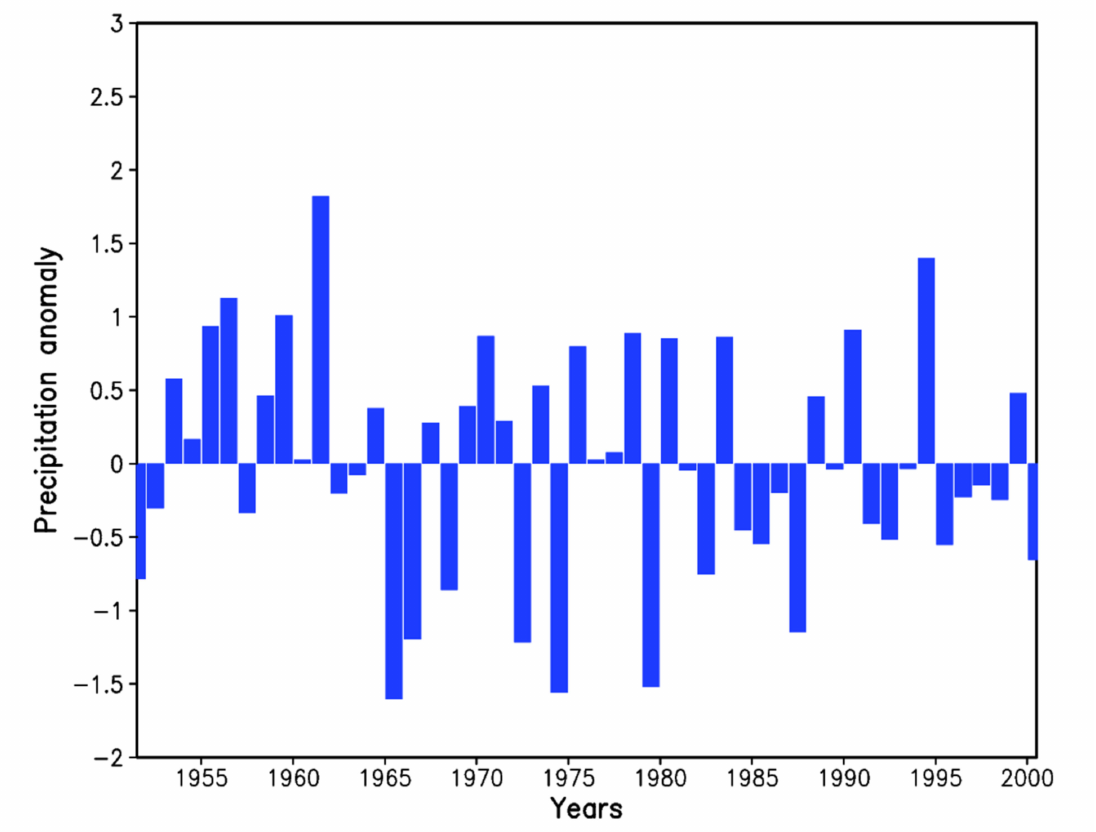
Figure 1. Time series of JJAS standardized area-averaged precipitation anomaly index for the central India region (74.5 ◦ E–86 ◦ E, 16.5 ◦ N–26.5 ◦ N). Climatology is based on the APHRODITE precipitation dataset